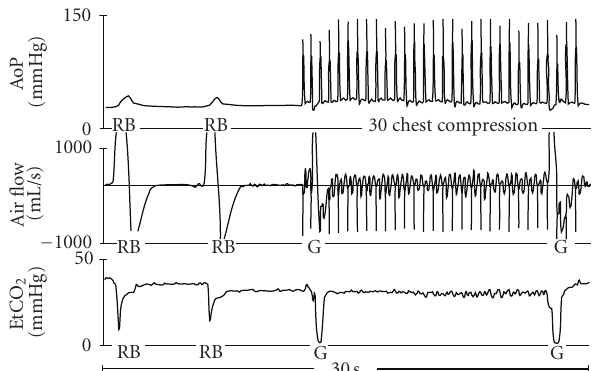
Figure 2: Graphic recordings of aortic pressure (AoP), air flow and end-tidal CO 2 (EtCO 2 ) of a swine in the 30 :2-CPR group. RB indicates rescue breathing produced by exhaled air. G marks a